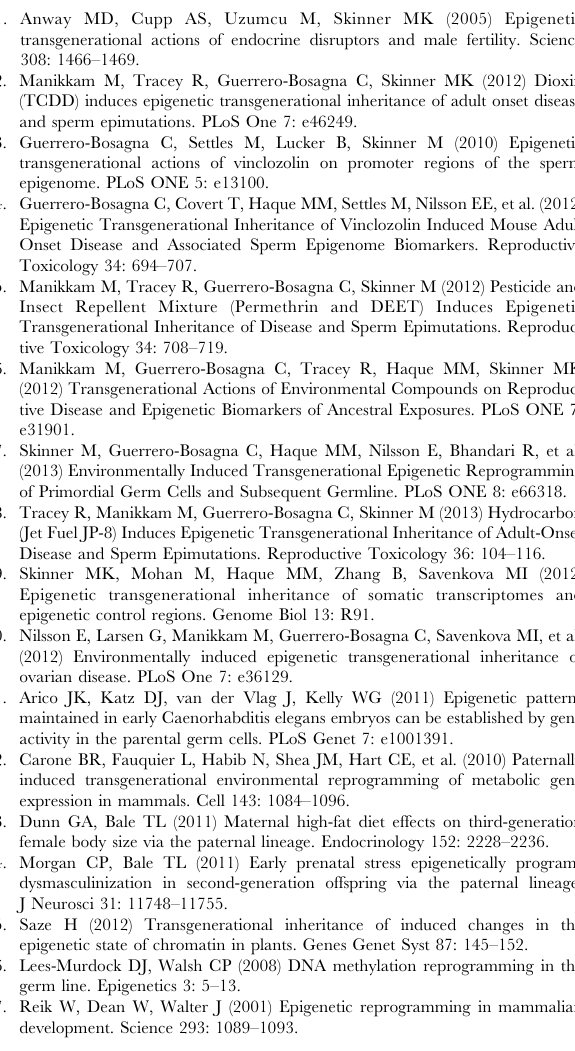
Figure S1 Validation with DDT DMR data set. (A) Distribution of A/T string (WWWW) incidence in the DDT DMR data set. The percent of DMR with A/T string sequences are presented compared to the random sequence data set. (B) Distribution of G quadruplexes (GGGG) incidence in the DDT DMR data set. The percent of DMR with G-quadruplexes are presented compared to a random sequence data set.